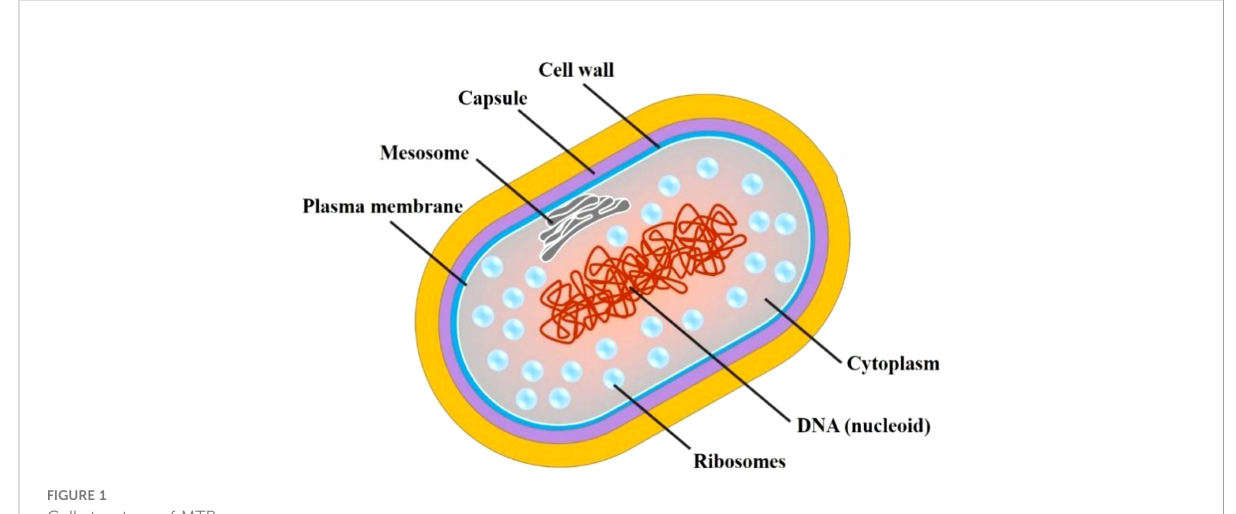
FIGURE 1 Cell structure of